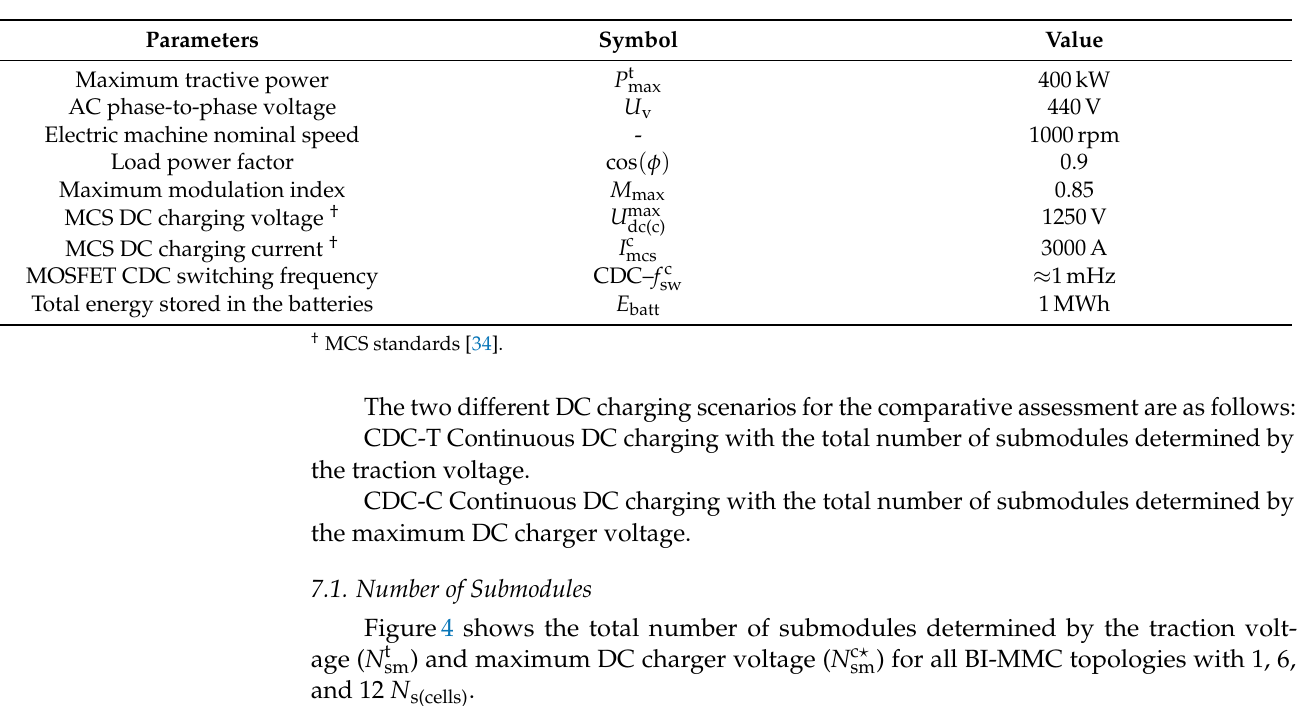
Table 1. Design parameters for a 400kW 40-ton commercial vehicle.